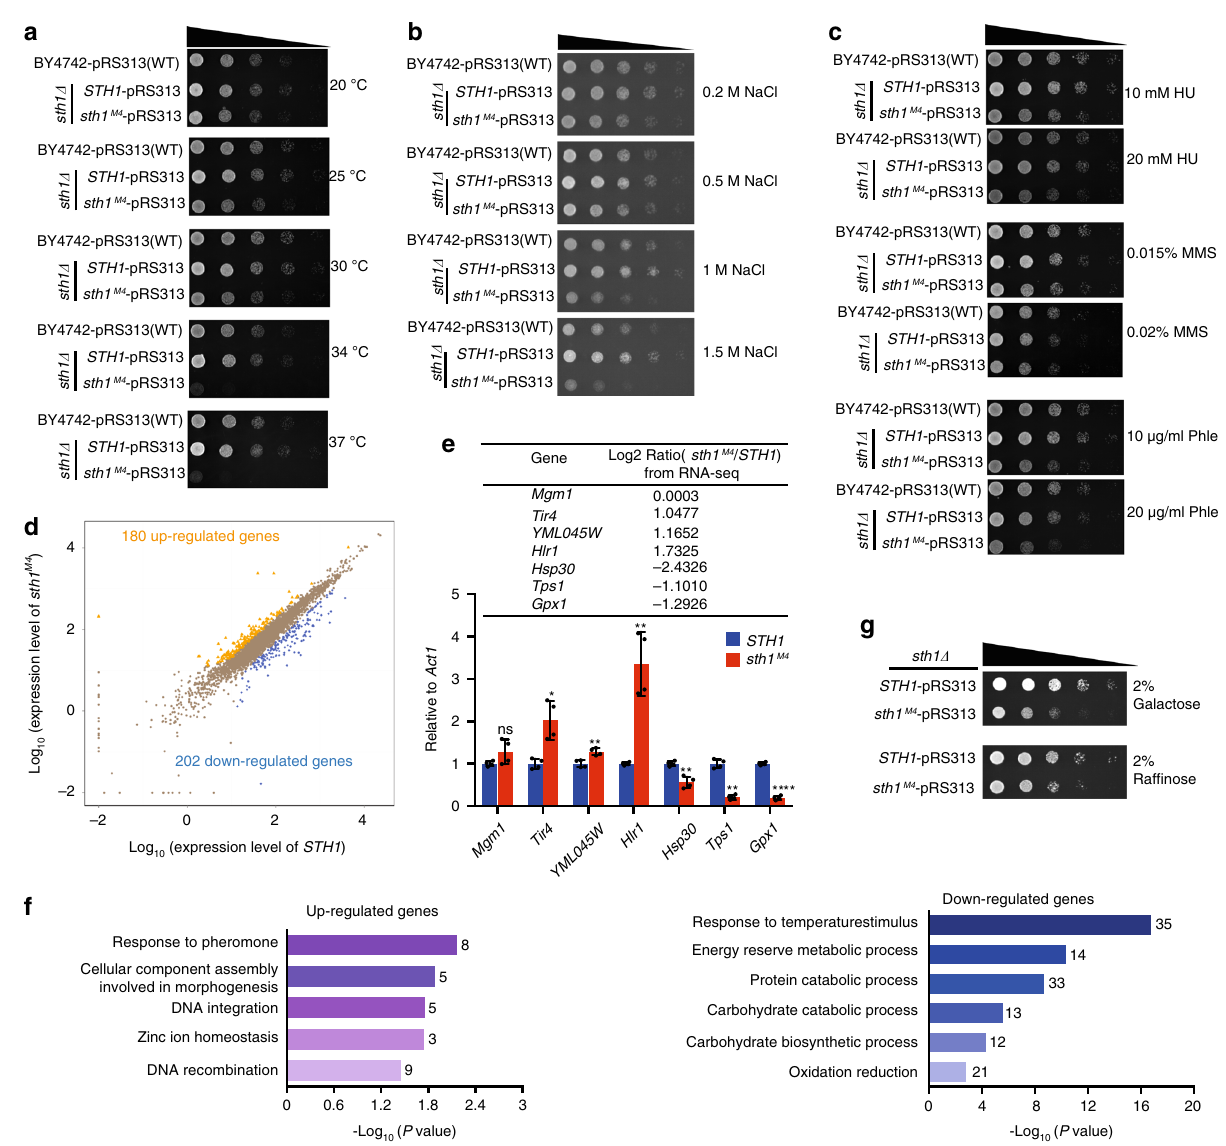
Fig. 3 Genetic analyses of the Taf14 – Sth1 interaction. a Spotting assays with sth1 Δ strains transformed with plasmids expressing full-length wild-type Sth1 or M4 mutant (L1204A/V1206A/I1208A/L1210A) at different temperatures. b Spotting assays with sth1 Δ strains transformed with plasmids expressing full-length wild-type Sth1 or M4 mutant at different NaCl concentrations at 30 °C. c Spotting assays with sth1 Δ strains transformed with plasmids expressing full-length wild-type or M4 mutant STH1 on plates containing hydroxyurea (HU), methyl methanesulfonate (MMS), and phleomycin (Phle) at two different concentrations at 30 °C. d Scatter plot of log 10 normalized gene counts in the STH1 and sth1 M4 strains. 108 genes were signi fi cantly (>2-fold change) upregulated (orange) and 202 genes were downregulated (blue) in the sth1 M4 strain. e The qPCR validation of the RNA-seq results. Tir4 , YML045W , and Hlr1 were upregulated, while Hsp30 , Tps1 , and Gpx1 were downregulated in sth1 M4 strains. The Mgm1 transcription level is not regulated by Sth1. The change levels from RNA-seq were shown. Error bars represent standard deviations of four replicates. The relative expression level of wild-type STH1 strain genes was set to 1. * for P < 0.05; ** for P < 0.01; *** for P < 0.001; **** for P < 0.0001; two-tailed Student ’ s t -test. Data are presented as mean ± SD, n = 4. Source data are provided as a Source Data fi le. f Gene ontology analysis of the upregulated and downregulated differentially expressed genes. g Spotting assays of sth1 Δ strains transformed with plasmids expressing full-length STH1 or sth1 M4 on plates with galactose or raf fi nose as the sole carbon source at 30